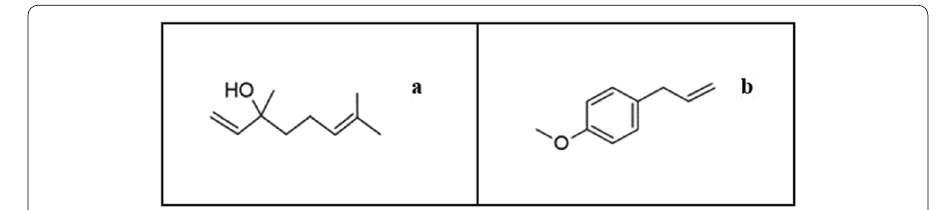
Fig. 4 Chemical structures of main component of basil oil. a Linalool and b